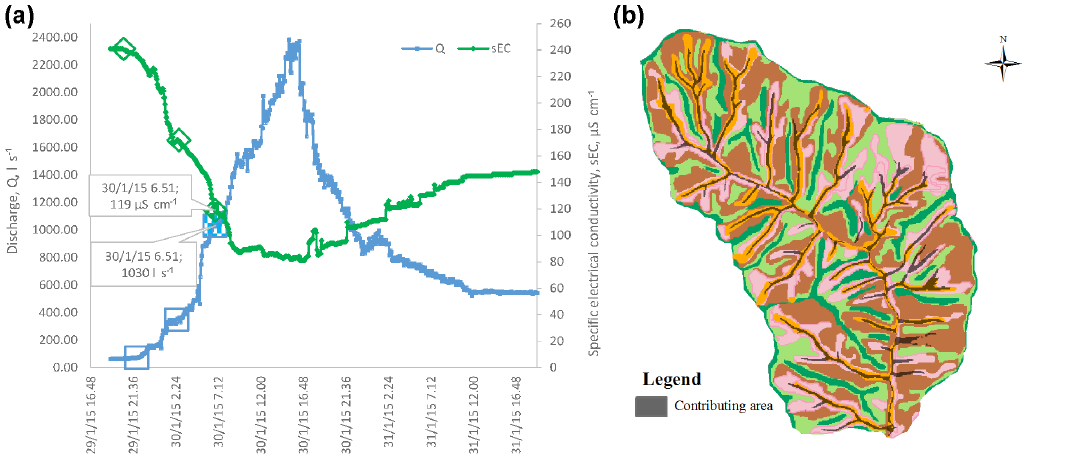
Figure 11. (a) Progressive hydro-chemograph conditions after approximately 60mm of rainfall, with approximately Q = 1000Ls − 1 , filled blue square, and approximately EC = 120µS − 1 , filled green diamond, (b) scenarios corresponding to a full saturation excess contribution to streamflow along the riparian corridor and at transient channels within the colluvial hollows, respectively.